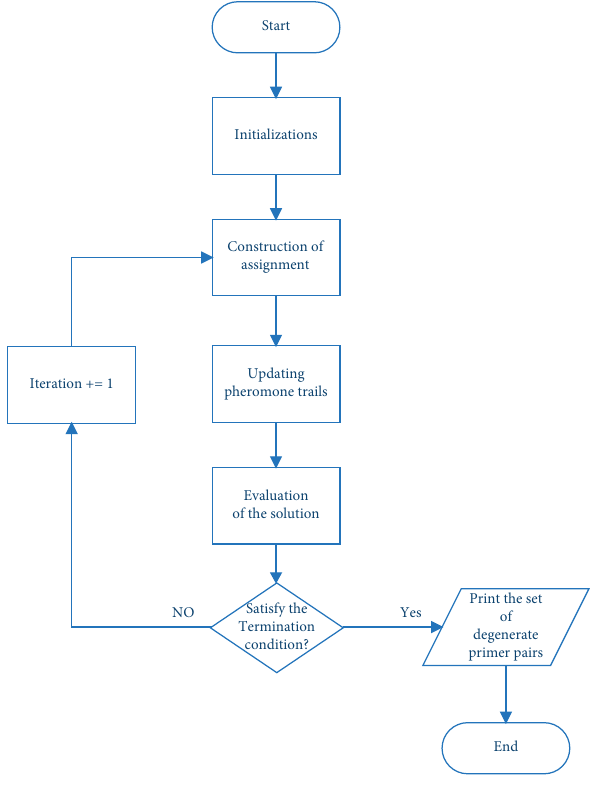
Figure 1: ACOH for solving